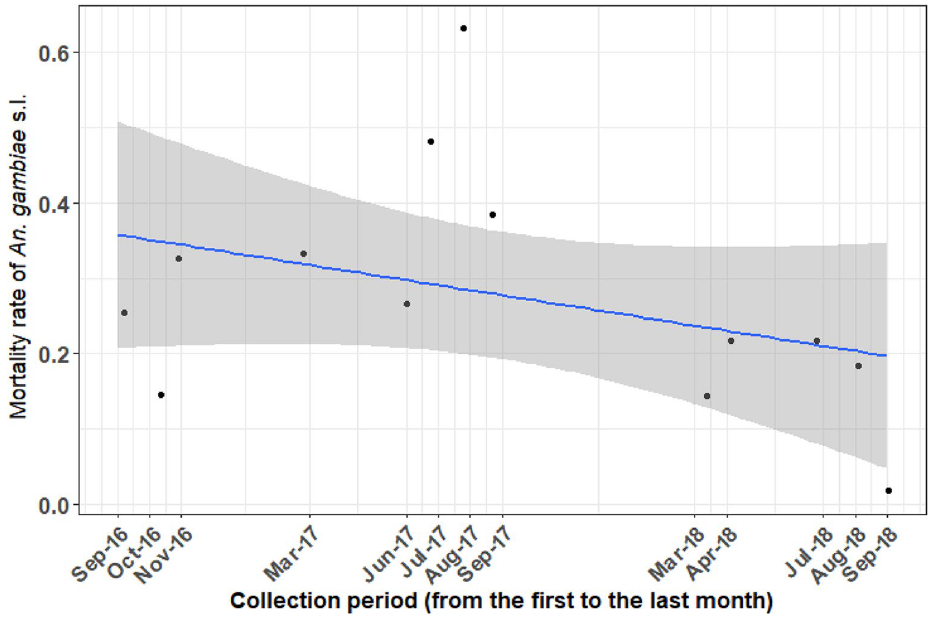
Figure 1. Mean predicted mortality of Anopheles gambia e s.l. 24 h following exposure to a diagnostic dose of deltamethrin across the study period. Black dots indicate mean predicted mortality at each study month between September 2016 to September 2018 across 9 villages in southwestern Burkina Faso. The blue line indicates the predicted linear change in An. gambiae s.l. across the study period based on the final model, with the grey-shaded area indicating the 95% confidence